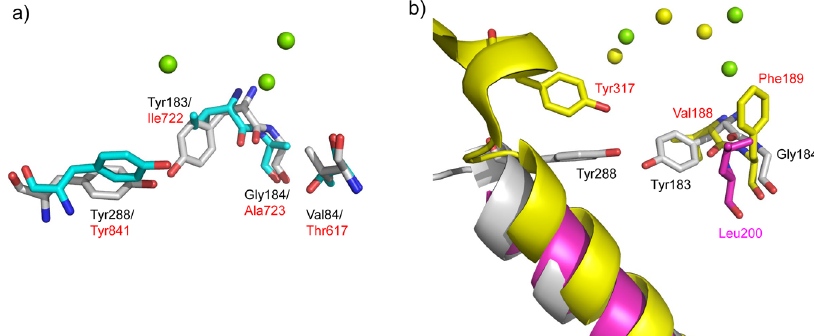
Fig. 6 The key residues in the active sites of Sat1646-Mg 2 + , Stt4548, LrdC, and AgAS. a The comparison of key residues in the active sites of Sat1646- Mg 2 + (residues in gray and Mg 2 + ions in green spheres) and AgAS (residues in cyan). b The comparison of key residues in the active sites of Sat1646- Mg 2 + (residues in gray and Mg 2 + ions in green spheres), Stt4548 (residues in magenta) and LrdC (residues in yellow and Mg 2 + ions in yellow